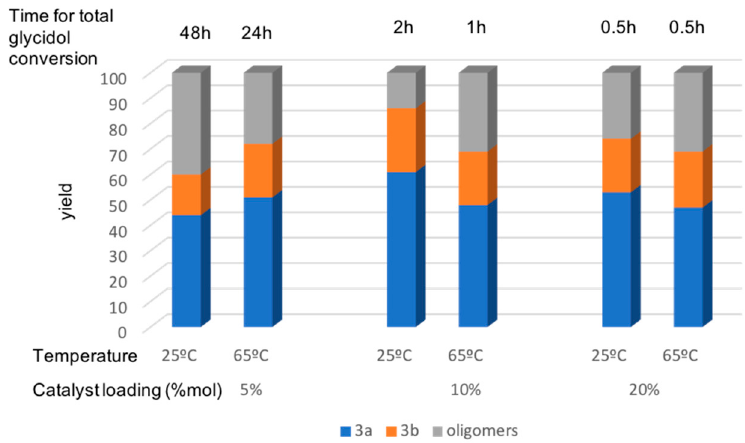
Figure 1. Influence of catalyst loading and reaction temperature in glycidol ( 1 ) conversion and